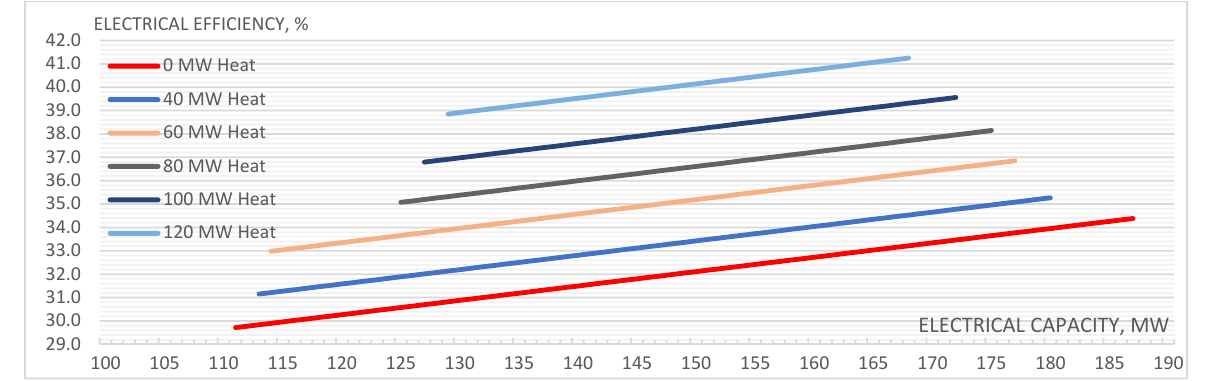
Figure 6. Linear function of electrical efficiency based on the heat load.